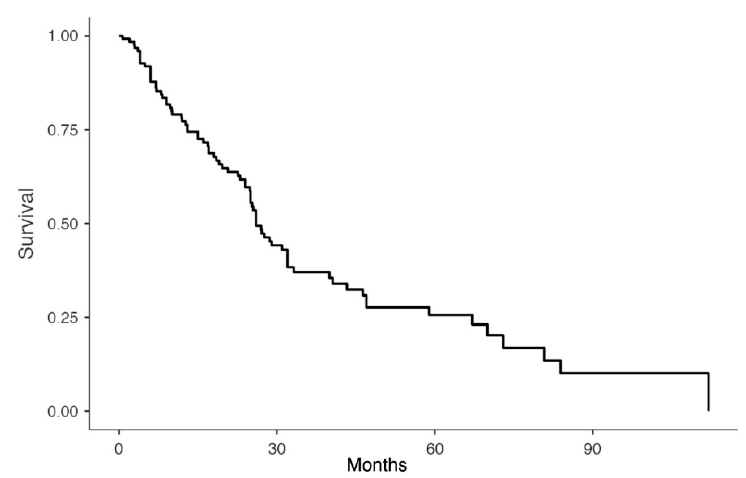
Figure 3. Survival after recurrence resection.